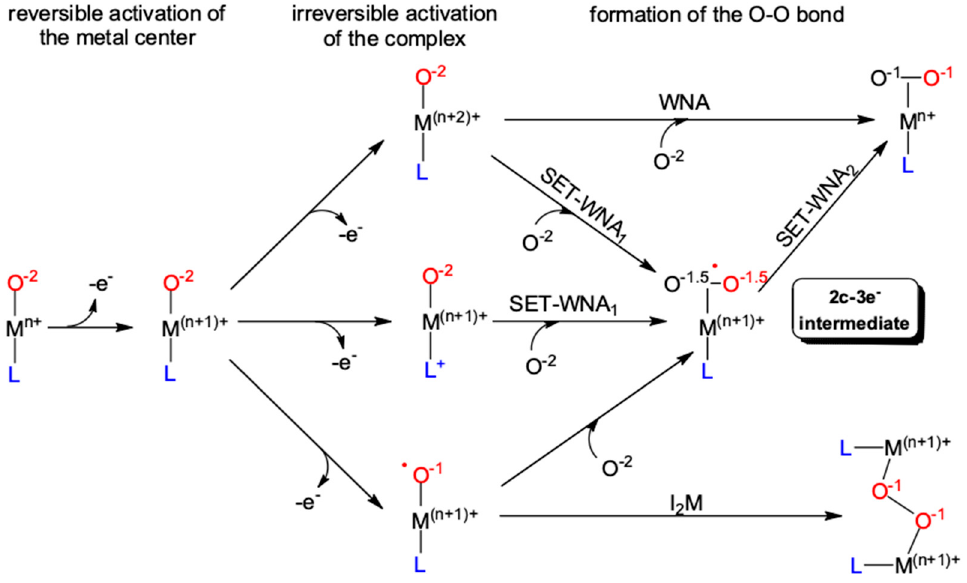
Figure 18. Mechanistic scenarios for single-site Cu-catalysts, protons were omitted [29].